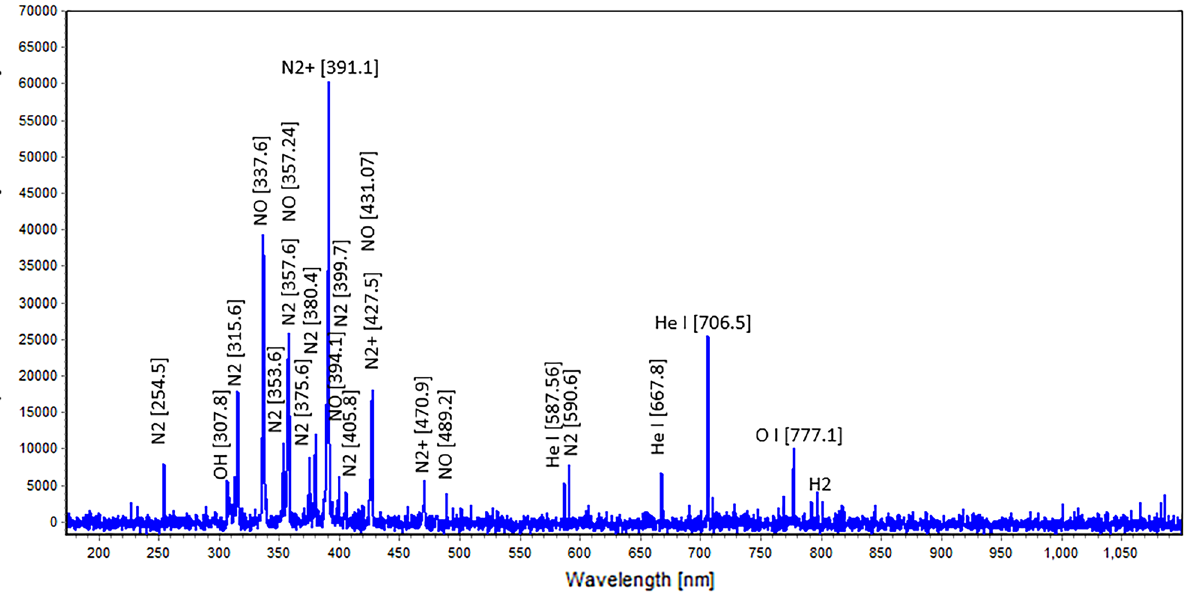
Figure 1. OES spectrum of He